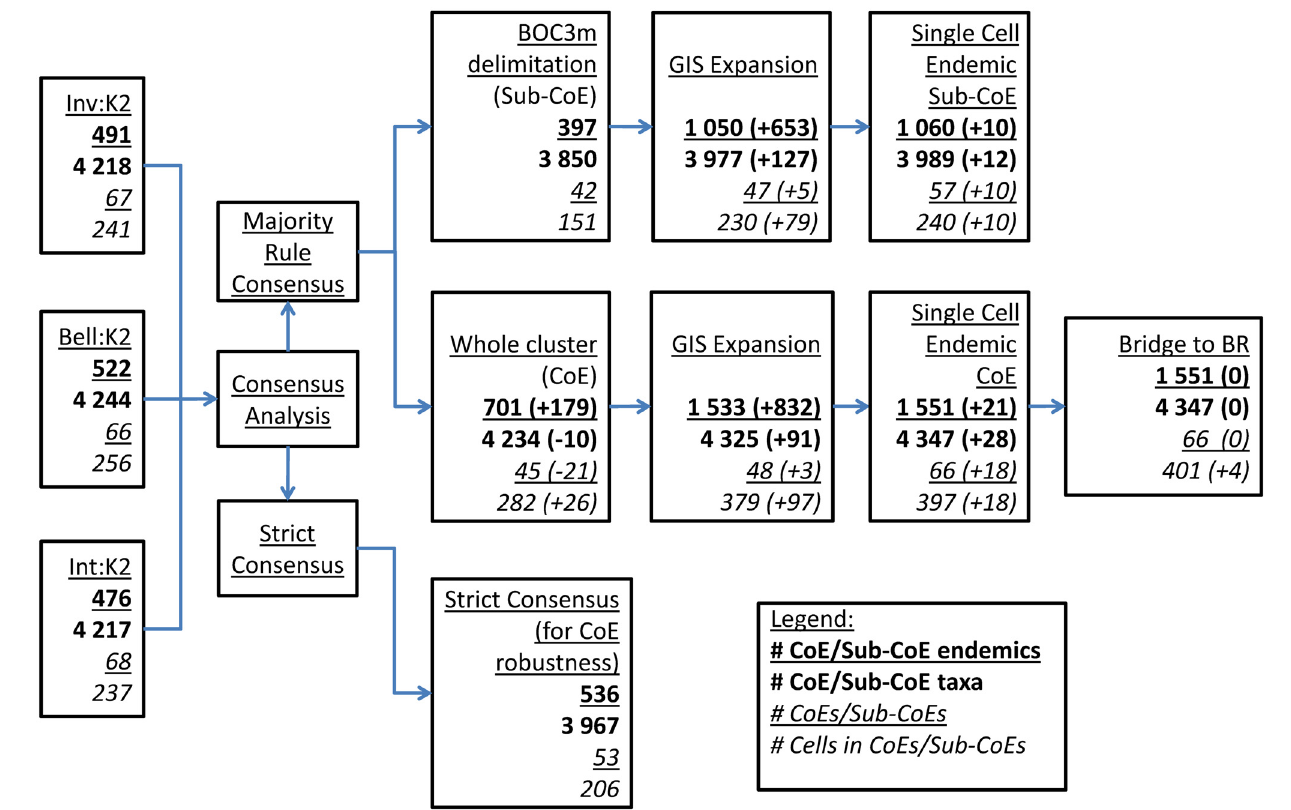
Fig 8. Flow chart summary of the change in CoE properties from clustering to GIS interrogation. CoE properties (endemic taxa, richness, number and size of CoEs / Sub-CoEs) of the best clustering technique results (Inv:K2, Bell:K2 & Int:K2), showing the effects of applying majority rule and strict consensus on CoE/Sub-CoE properties are depicted (the legend indicates what each number row refers to in each block). Also displayed are the improvements of CoE / Sub-CoE properties with GIS interrogation (the values in brackets indicate additional taxa or cells added to CoEs). Finally, the minimal changes required in CoE properties are reported when converting CoEs to